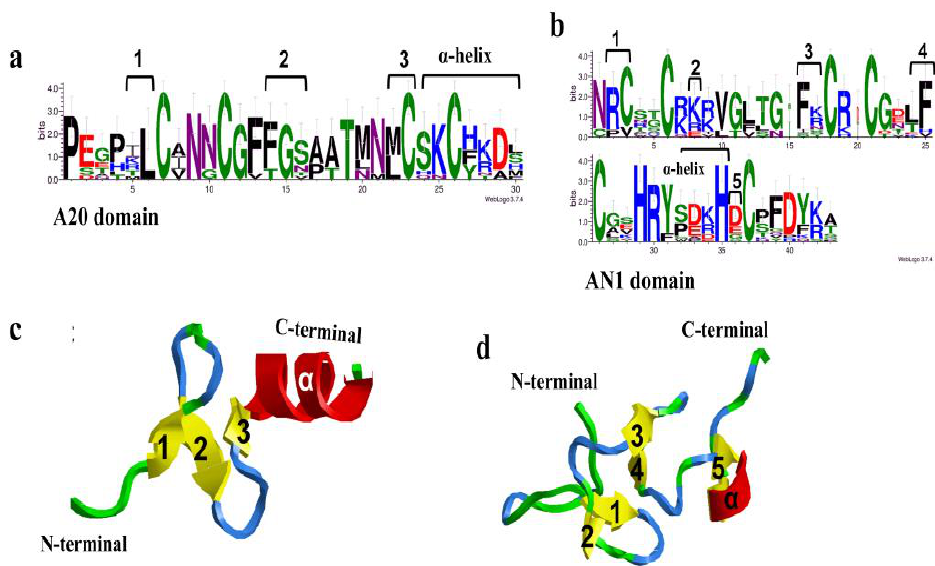
Figure 2. ( a ) Sequence logos of A20 domain in the CsSAPs. ( b ) Sequence logos of the AN1 domain in the CsSAPs. ( c ) Three-dimensional tertiary structural model of the A20 domain (PDB ID: 2KZY.1.A); and ( d ) three-dimensional tertiary structural model of the AN1 domain (PDB ID: 1WFP.1.A). The logos of the A20 and AN1 domains were obtained through multiple alignments of the CsSAPs. In each stack, the symbol height represents the relative frequency of each amino acid at that position; numbers 1–5 represent β -sheets in A20 and AN1 domains; α -helices are red, β -sheets (numbers 1–5) are yellow, and strands are blue/green.